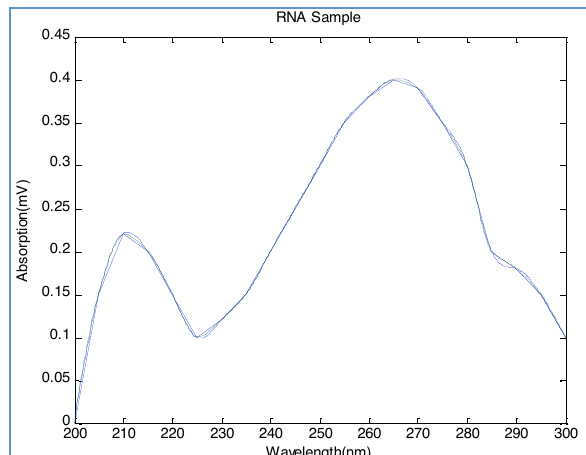
Figure 10. The absorbance of RNA sample